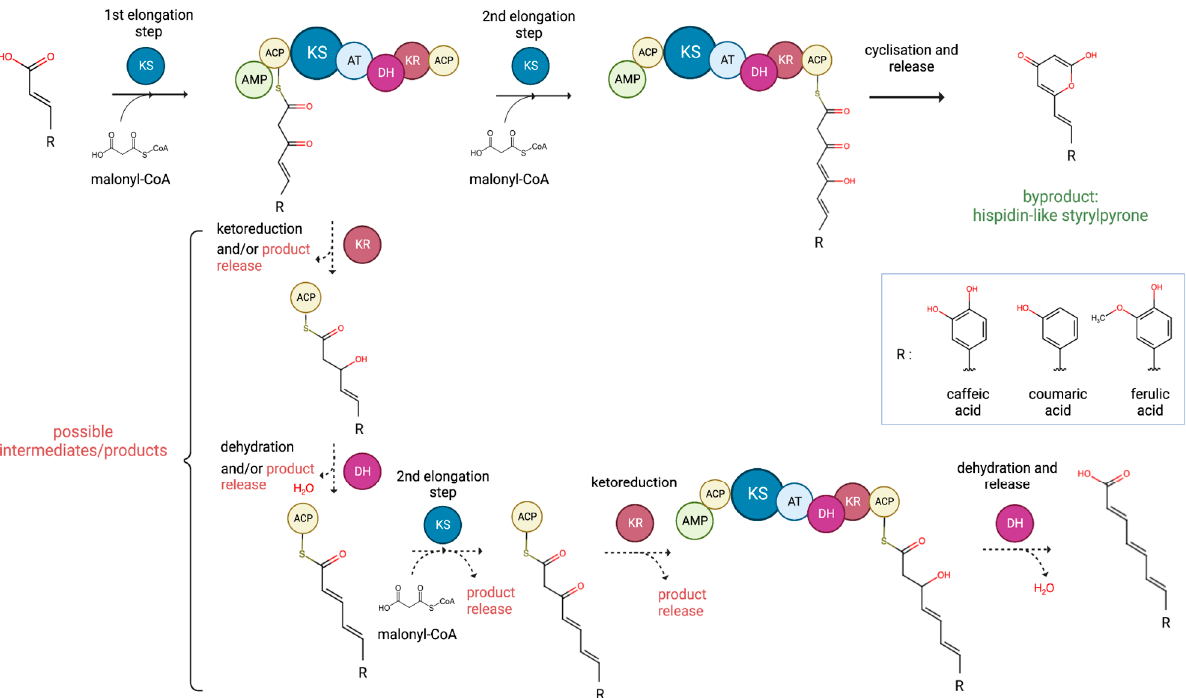
Figure 6. Proposed biosynthetic mechanism of styrylpyrones by hsPKS depending on a substrate. KS—ketosynthase, AT—acyltransferase, ACP—acyl carrier protein, AMP—AMP-binding domain, KR—ketoreductase, DH—dehydratase.